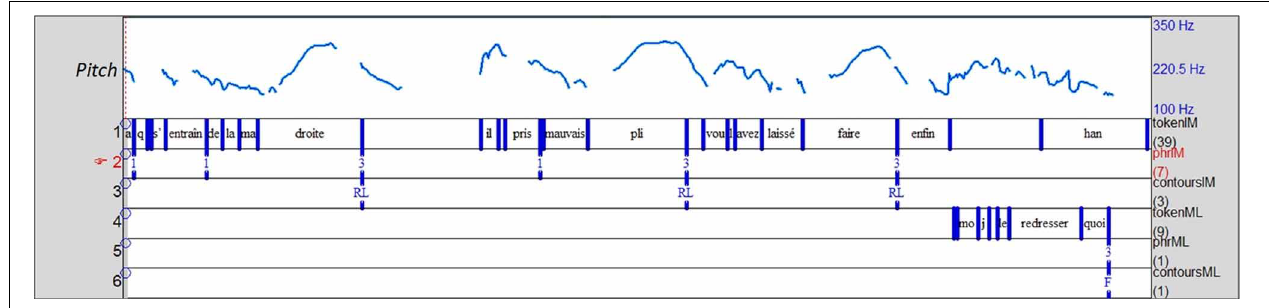
FIGURE 3 | Prosodic complementation in the enumerative structure co-produced by the storyteller (tier1) and the listener (tier4). The last three items -“ droite /right,” “ pli /habit,” and “ faire /do”- end in an intonative